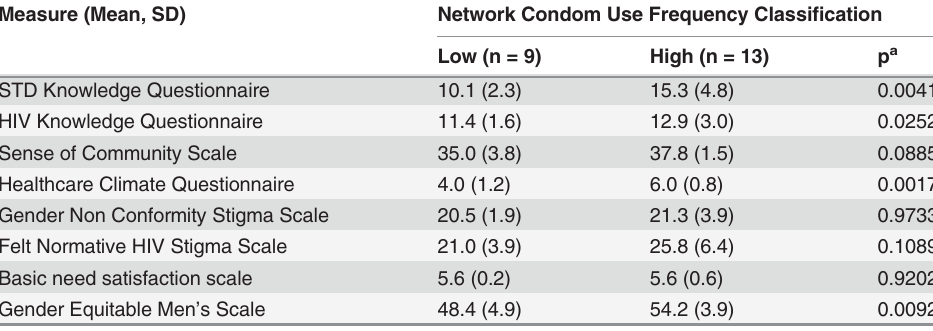
Table 8. Comparison of Low and High Frequency Condom Using Peer Social Networks on Psychosocial Variable Scores. Measure (Mean,